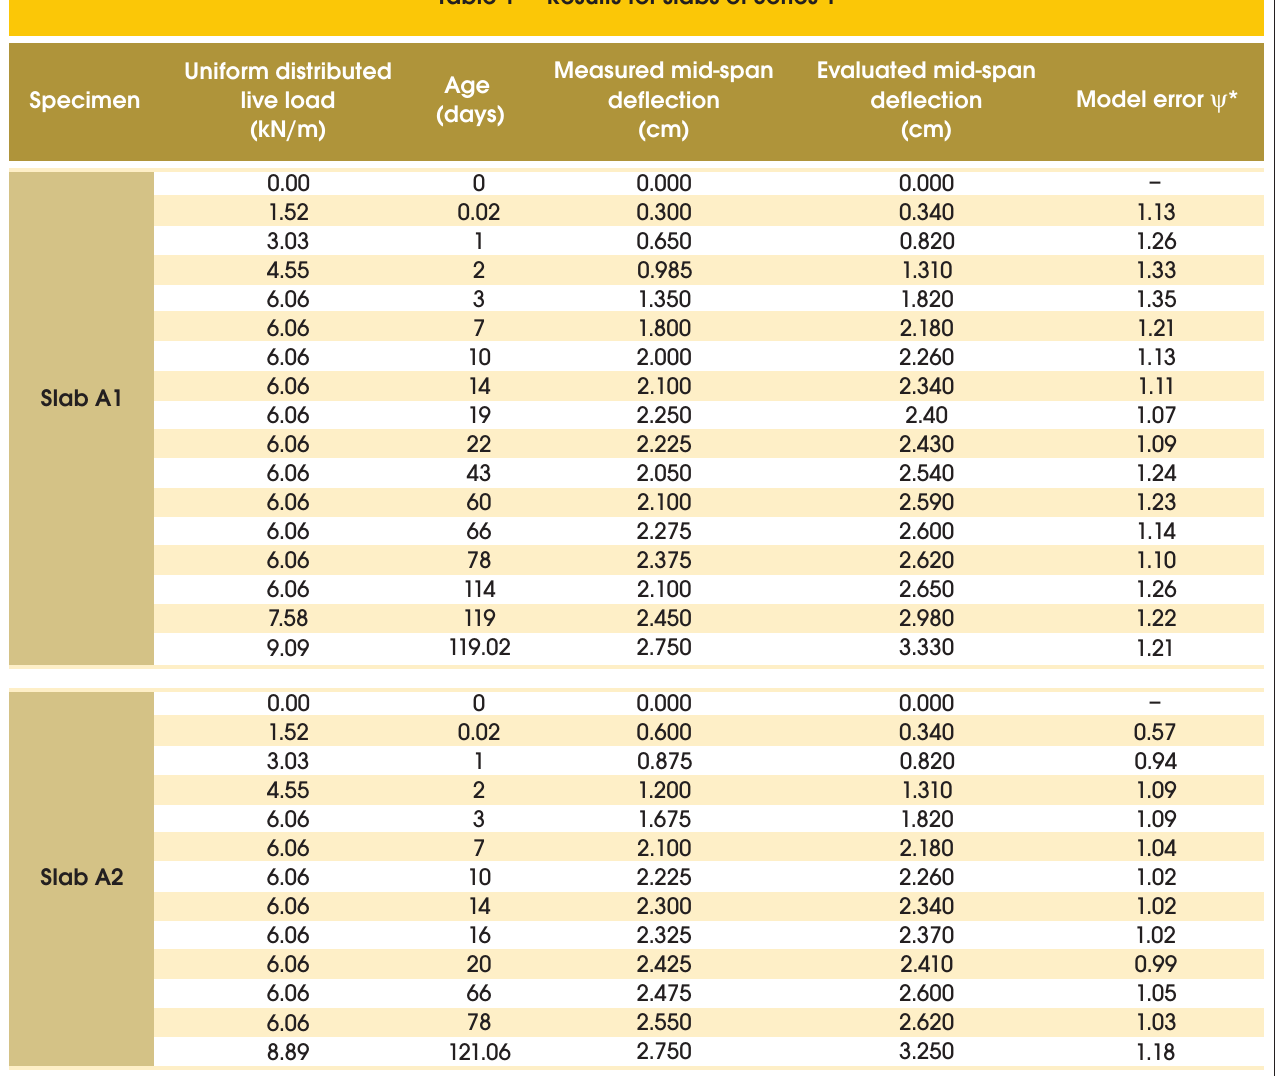
table 2. The comparison between the actual and predicted overall behavior can be quantified based on the model error y defined as the ratio between the evaluated mid-span deflection and the measured value. Values of y (last columns of tables 1 and 2) smaller than the unity indicate a stiffer behavior predicted by the numerical model. Each graph, on the other hand, shows an overall visual